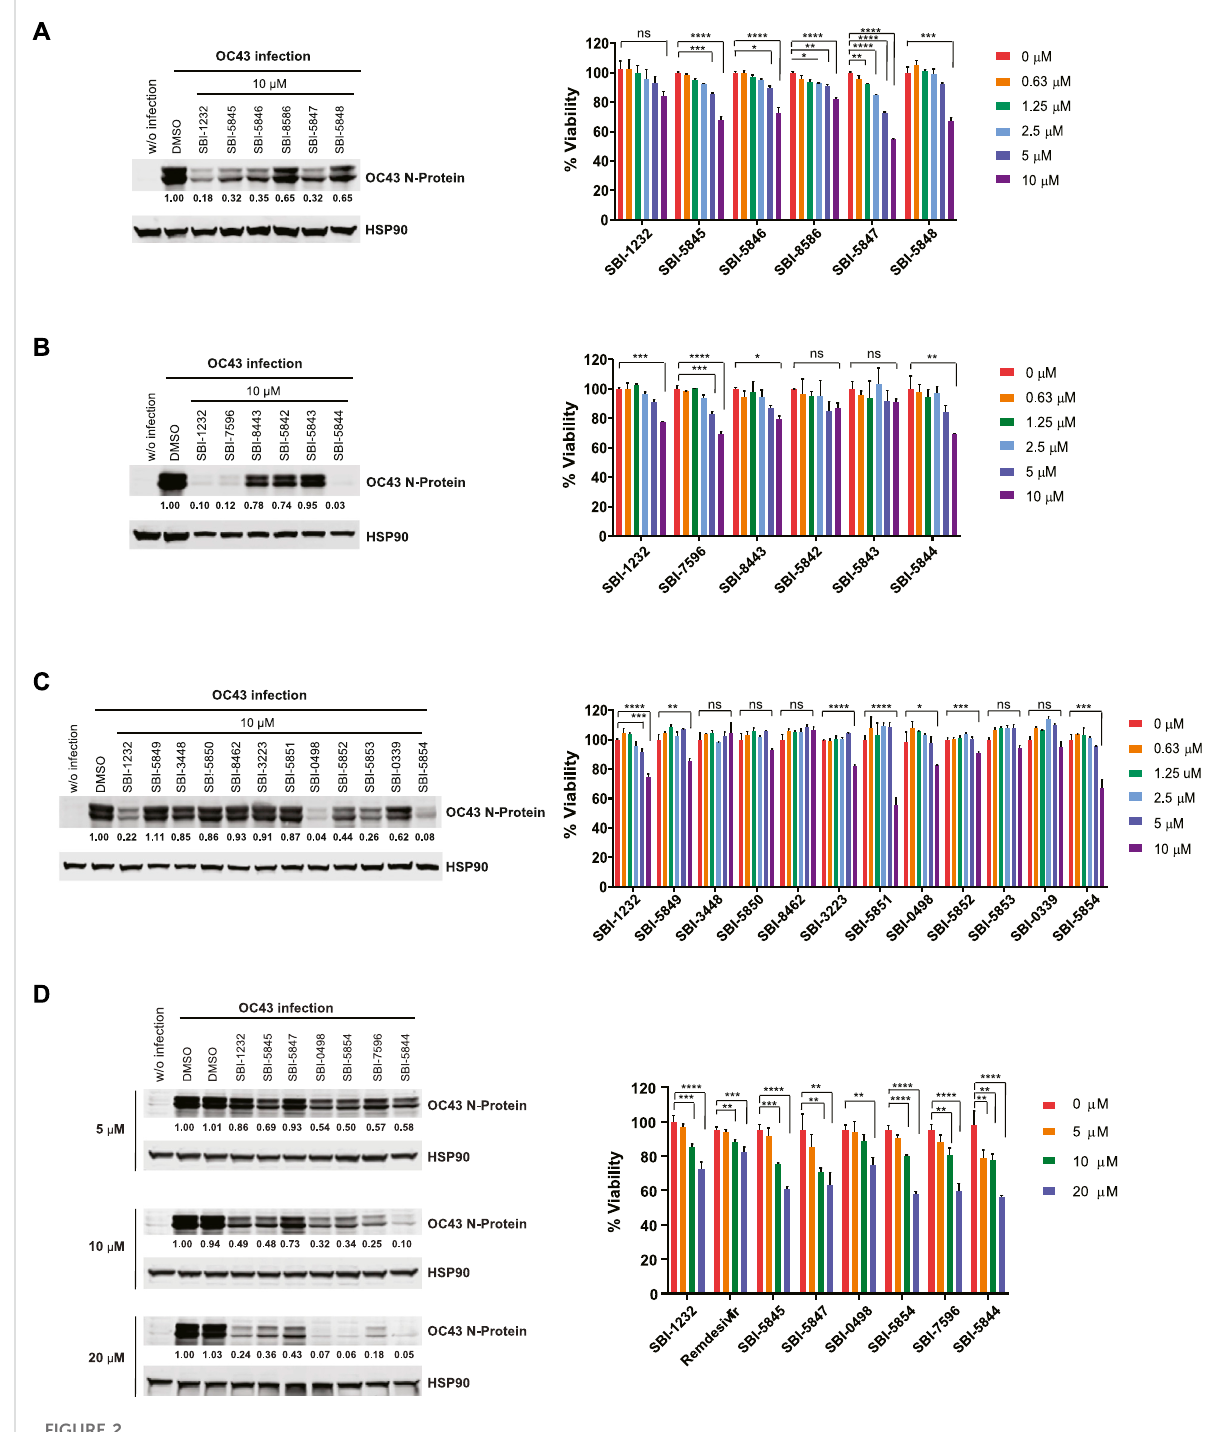
FIGURE 2 ValidationofSBI-1232analogsforinhibitionofOC43N-proteinexpression. (A,B,CandD) Left,Westernblotanalysisofindicatedproteinsfrom Vero E6 cells (2 x 105) infected with OC43 and treated with indicated compounds for 24 h. Band intensities were quanti fi ed against loading control HSP90, as shown below blots. Right panel, viability assay of uninfected Vero E6 cells 48 h after treatment with indicated compounds and concentrations. Statistical analysis was performed by one-way ANOVA for the comparison of more than two groups. Data are shown as the mean ± SD, n = 3. * p ≤ 0.05, ** p ≤ 0.01, *** p ≤ 0.001, **** p ≤